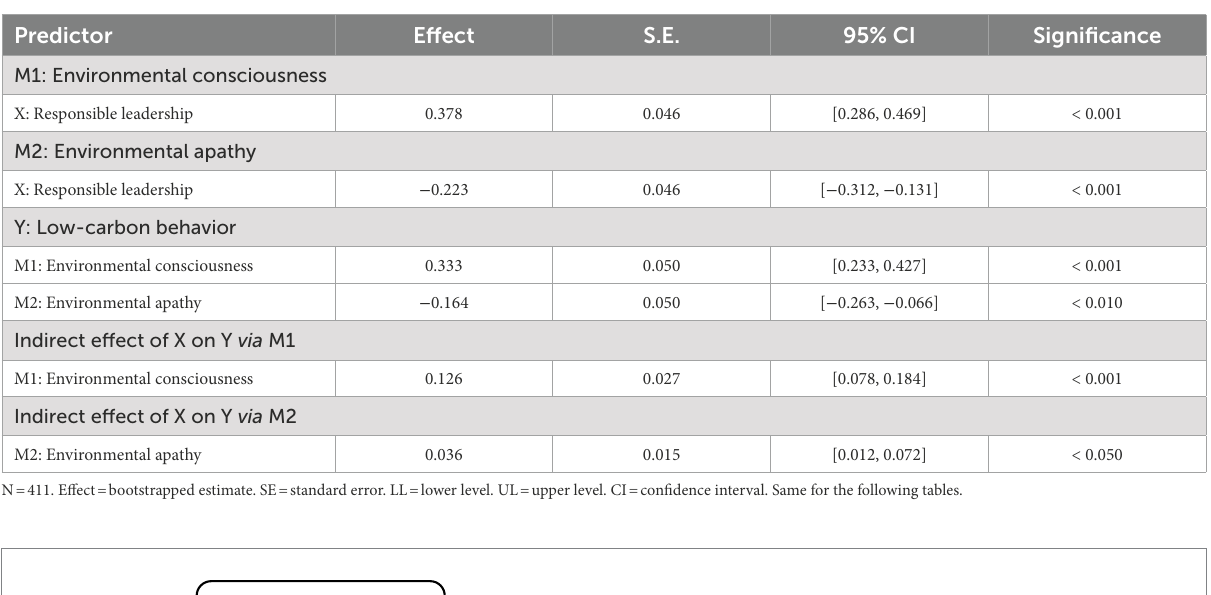
FIGURE 2 Unstandardized path coefficients from structural equation modeling